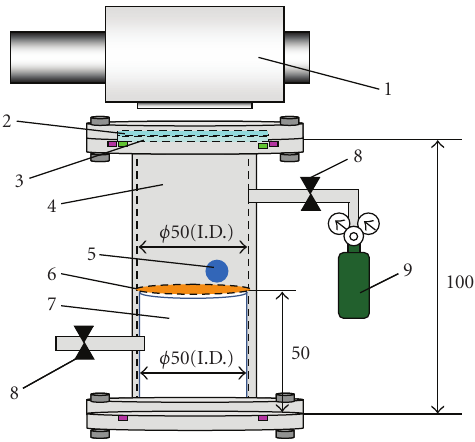
Figure 1: Schematic drawing of CO 2 reforming experimental